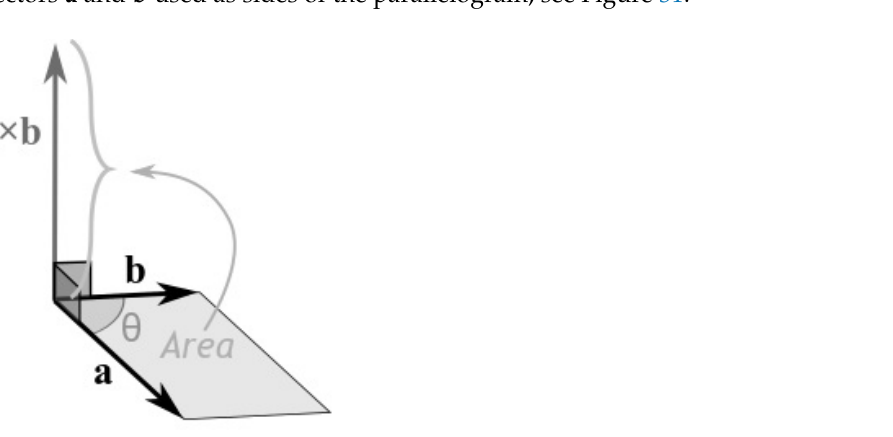
Figure 30. The cross product of 2 vectors is a third vector in the 3D space. The magnitude (length) of the cross product equals the area of a parallelogram with vectors a and b used as sides of the parallelogram; see Figure 31.